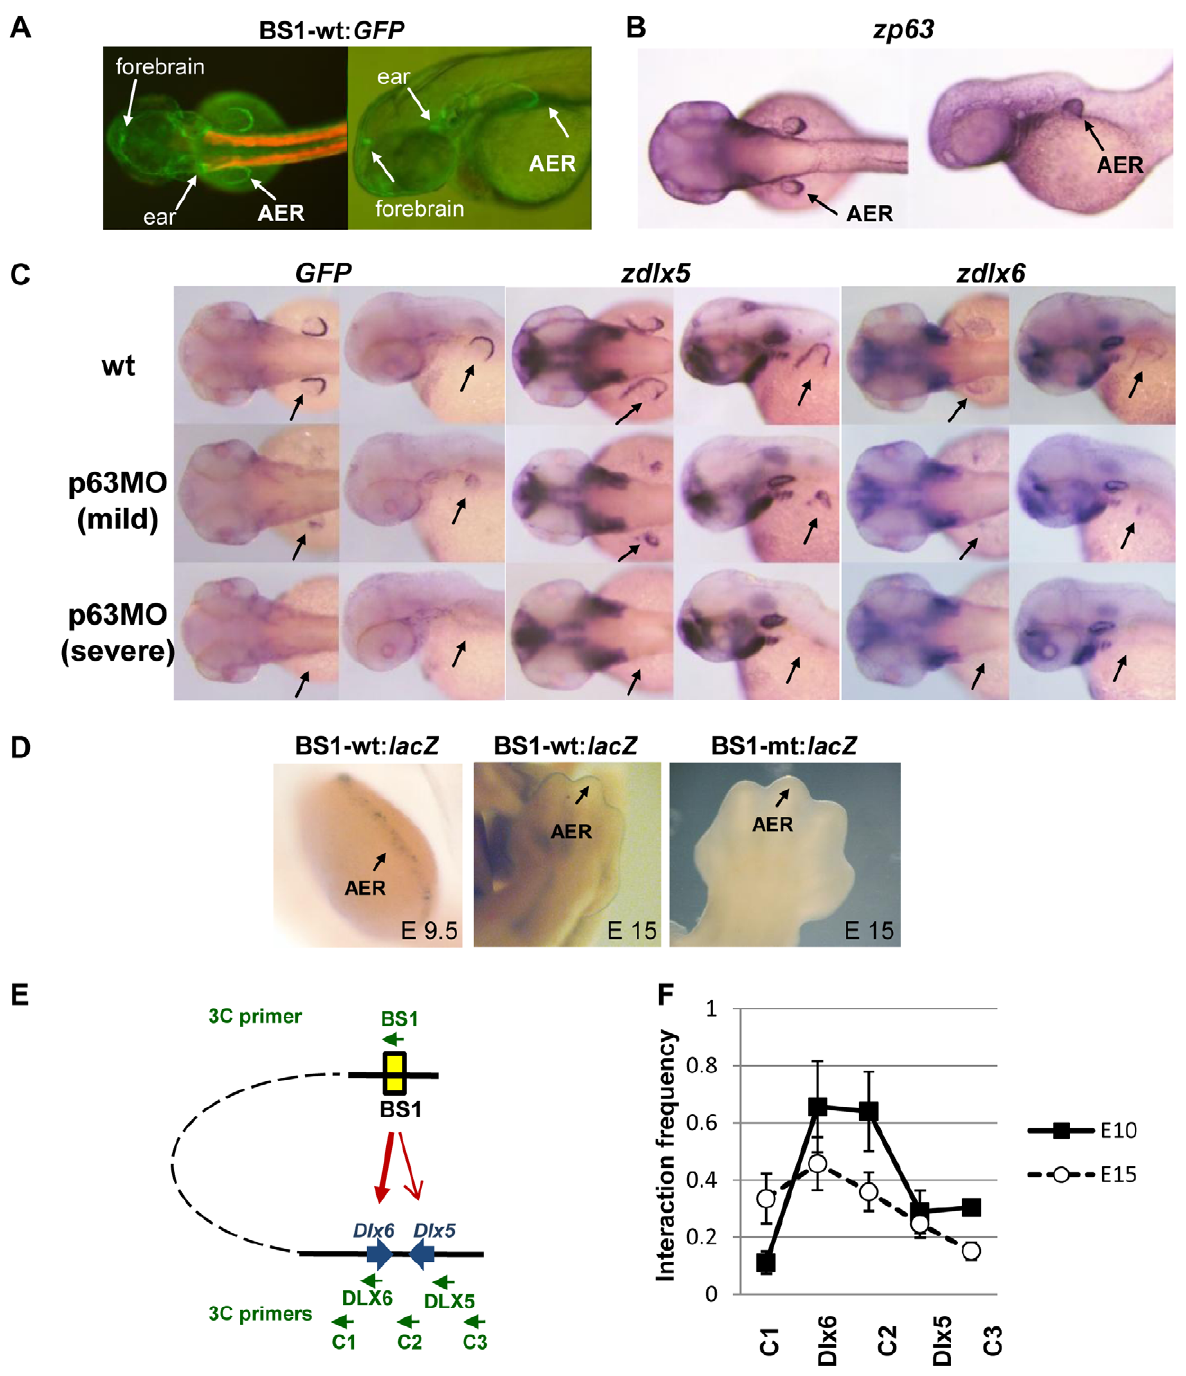
Figure 5. Functional analysis of SHFM1-BS1 to control gene expression in zebrafish and mice. (A) SHFM1-BS1 was cloned in a reporter construct carrying GFP . Expression of the GFP gene in zebrafish showed that SHFM1-BS1 can control gene expression at the apical ectodermal ridge (AER), the ear and the forebrain. The red fluorescence expressed in the muscles in the first zebrafish panel corresponds to the positive control of transgenesis. (B) Expression of zp63 in the AER was detected by in situ hybridization. (C) Expression patterns of transgene GFP controlled by SHFM1- BS1, zdlx5a and zdlx6a were analysed by in situ hybridization in 48hpf zebrafish embryos. The same specific expression of these genes was observed in the AER. Treatment of p63 morpholino in zebrafish embryos resulted in mild (reduced fins) and severe (no fins) phenotypes. Accordingly, the expression of GFP , zdlx5a and zdlx6a is either reduced or absent in p63 morphant embryos. (D) SHFM1-BS1 was cloned in a reporter construct carrying the LacZ gene to generate transgenic mice. Specific expression of LacZ in the AER was shown at E9.5 and E15. Mutations in the p63 binding motif in SHFM1-BS1 disrupted the specific expression pattern in mice (E15). (E) A diagram shows chromosomal locations of SHFM1-BS1 and Dlx5/Dlx6 . PCR primers used in the 3C experiment are indicated. (F) Three-dimensional physical interaction of SHFM1-BS1 to Dlx5/Dlx6 was analysed by Chromosome Conformation Capture (3C) technique in mouse embryonic limb tissues (E10 and E15). SHFM1-BS1 interacts strongly to the Dlx6 gene, as interaction frequency was clearly higher at the Dlx6 gene than at surrounding regions. Interaction frequency is expected to attenuate over distance to SHFM1-BS1 if there is no active interaction. Error bars represent standard errors (N=8 or 11 for E10 or E15 limbs, respectively). doi:10.1371/journal.pgen.1001065.g005 PLoS Genetics |